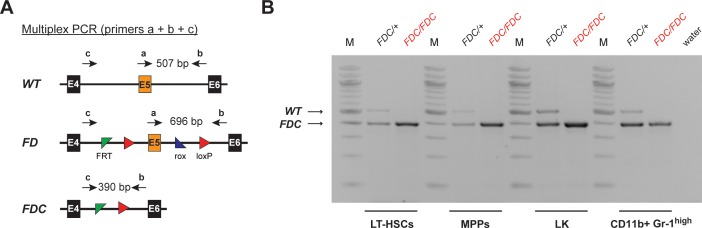
Complete recombination is achieved in FACS-sorted hematopoietic cell populations.(A) Multiplex PCR strategy allowing for the parallel detection of the FD, WT, and recombined FDC allele of Setd1b. Corresponding primer binding positions and expected amplicon sizes for the PCR are schematically illustrated. (B) Genotyping results in FACS-sorted LT-HSCs, MPPs, LK cells, and CD11b+ Gr-1high granulocytes from BM. Complete recombination was achieved in all analyzed cell populations from 25 weeks old Setd1bFD/FD;VC/+ vKO mice (n = 2) and Setd1bFD/+;VC/+ controls (n = 2). (M = molecular marker, E = exon, bp = base pairs).